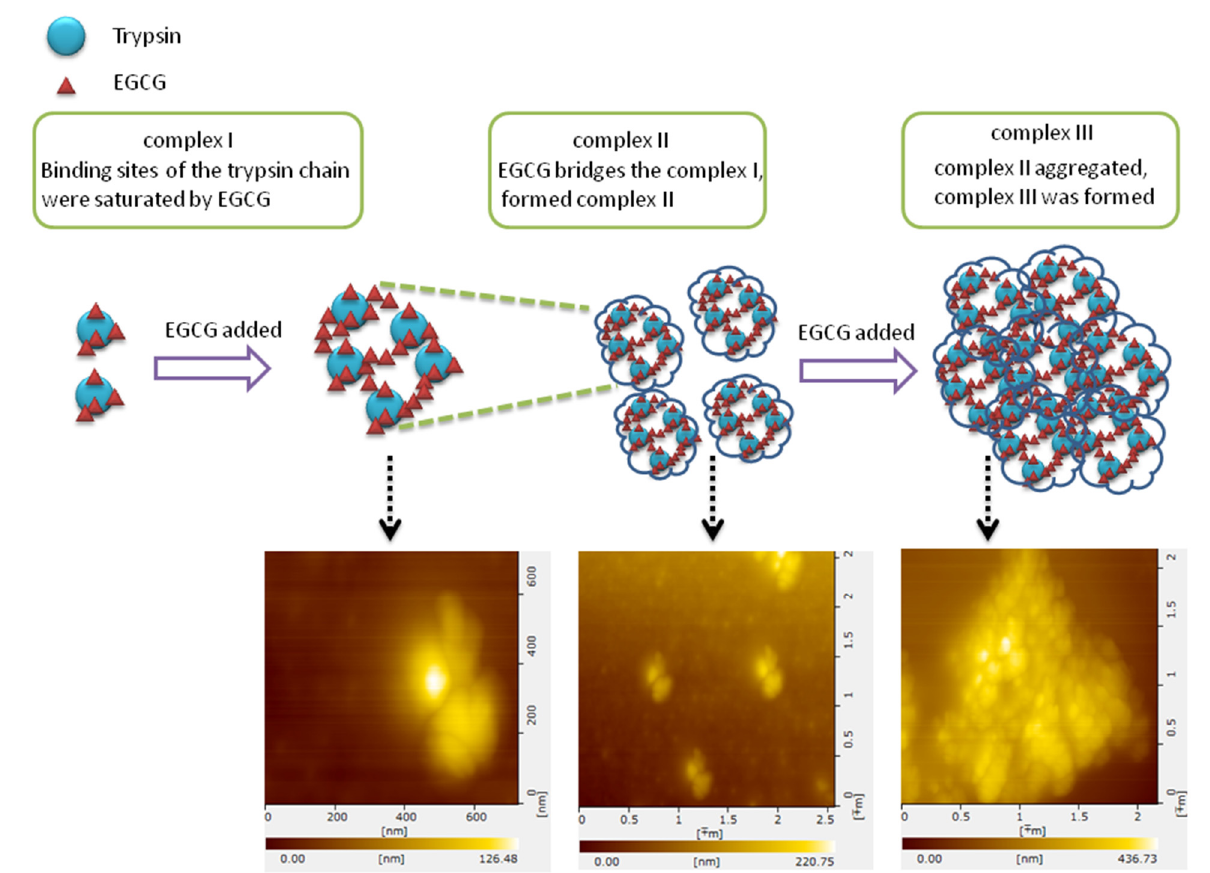
Figure 6. Schematic graph of the aggregate process.